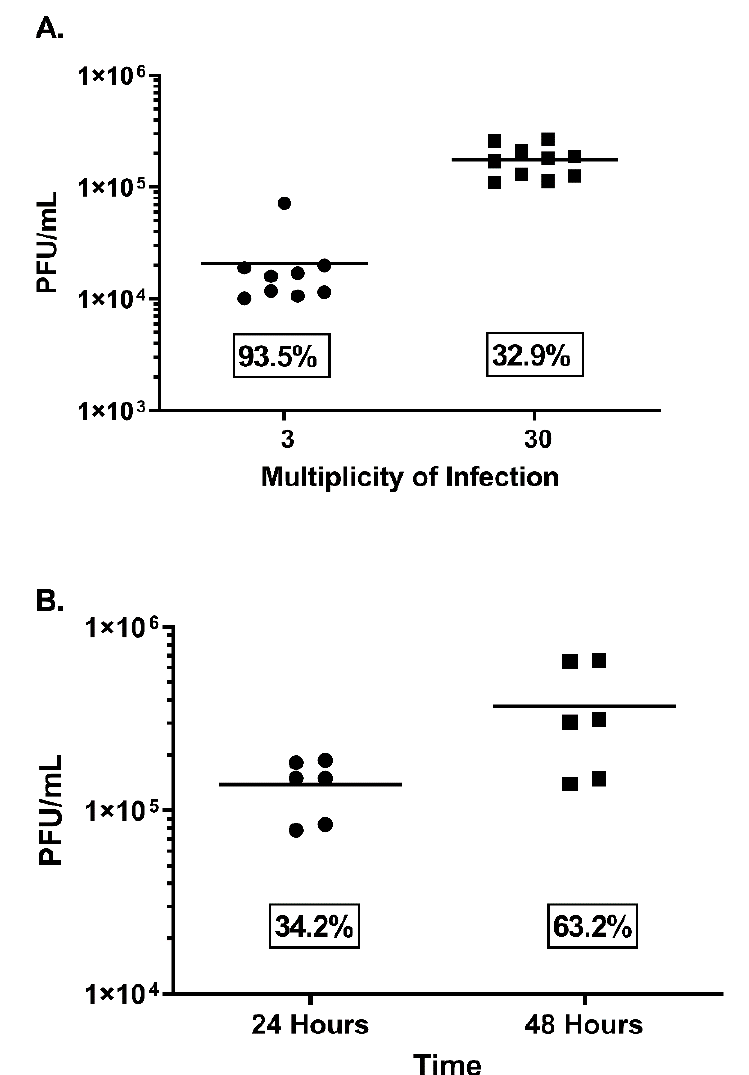
Figure 1. Evaluation of fresh preparations of monkeypox virus from supernatants using different multiplicities of infections and harvest times. High-multiplicity of infections (3 and 30 pfu/cell) were utilized for synchronization of viral infection on confluent Vero E6 cells plated in T175 flasks. Three experiments were conducted for each MOI ( A ) and time point ( B ). Titers are given (PFU/mL) as well as variability, as determined by % coefficient of variation (CV), and are shown in text boxes on the graph.